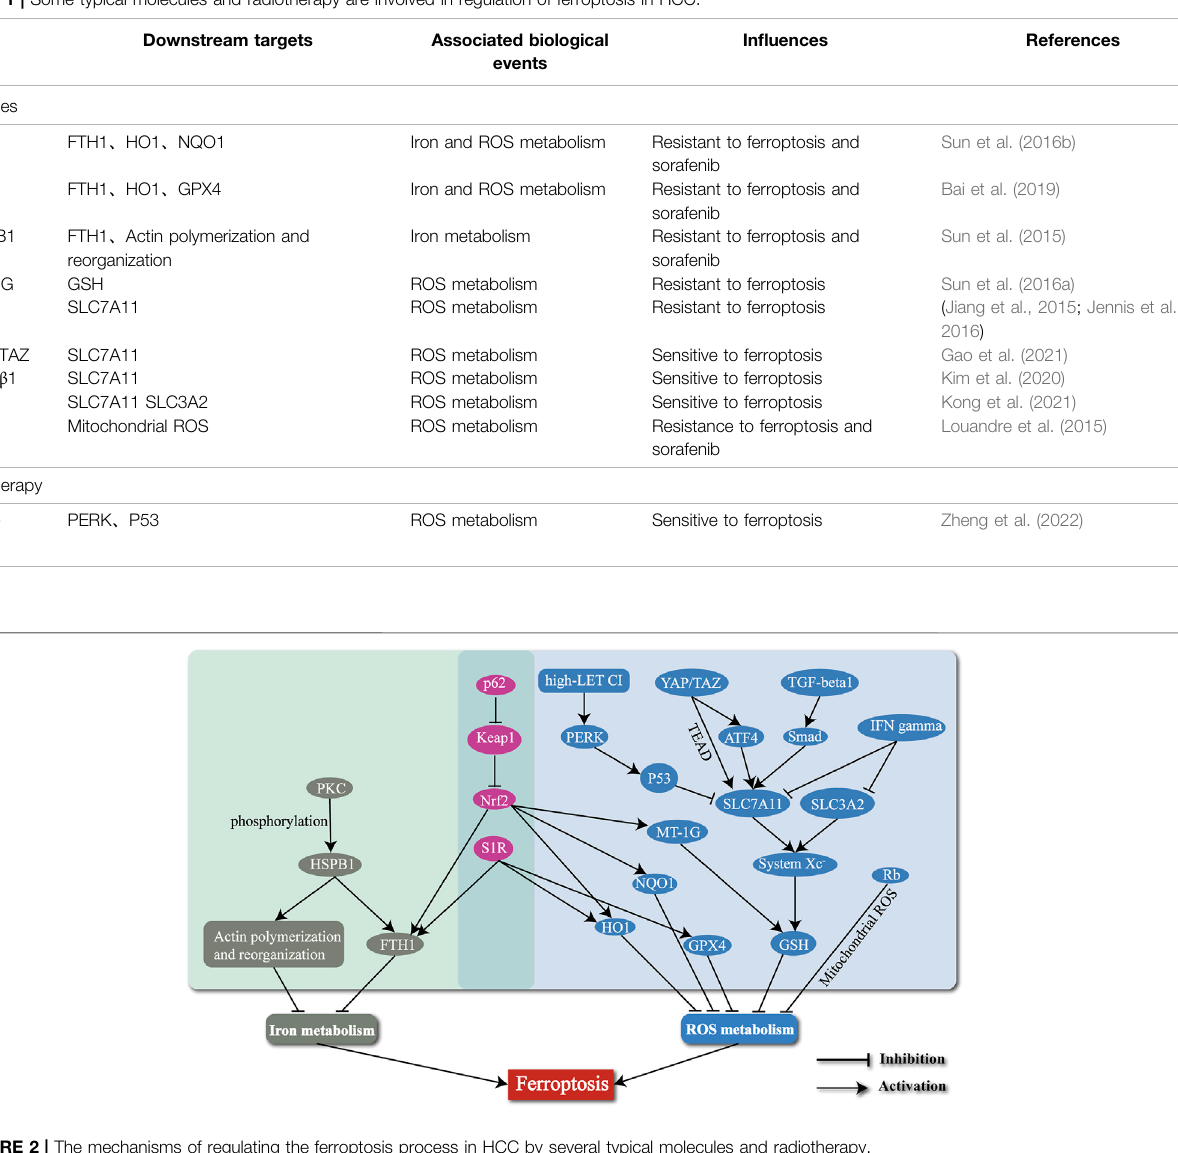
Frontiers in Cell and Developmental Biology |